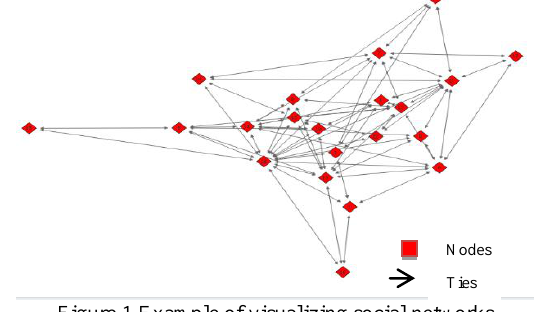
Figure 1 Example of visualizing social